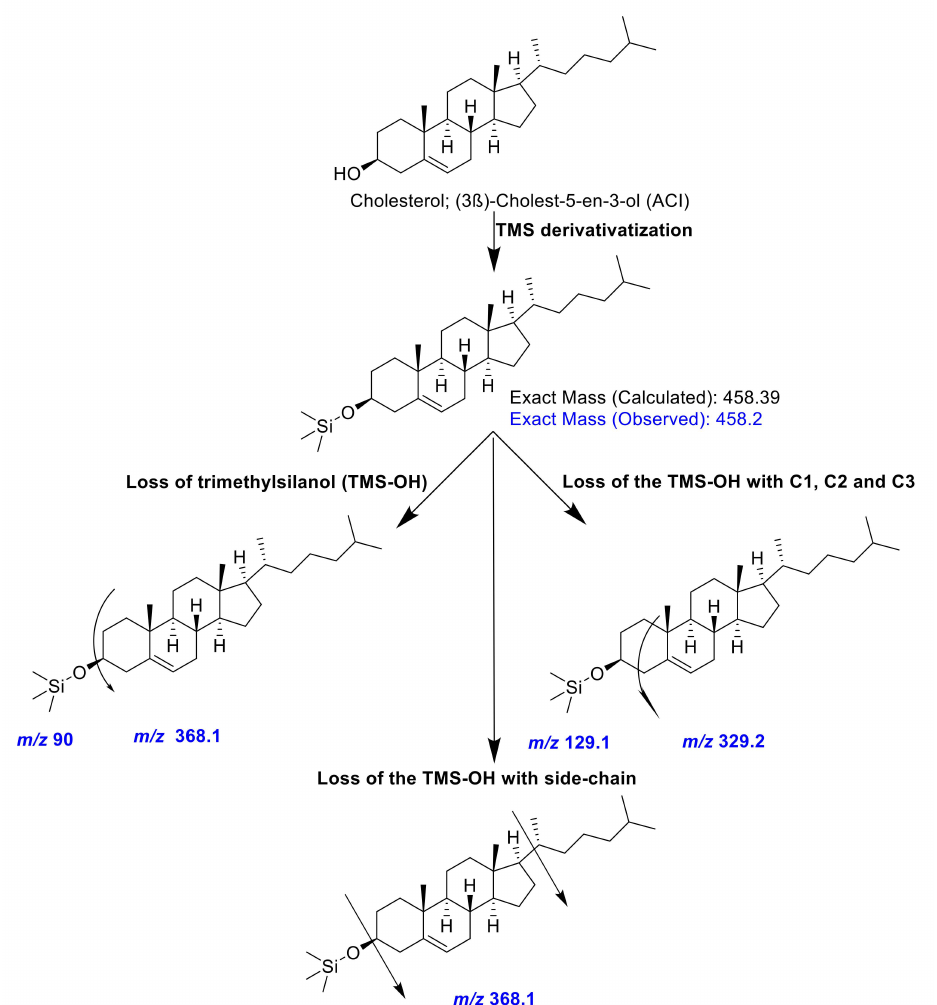
Figure 1. A representative mass-fragmentation pattern of cholesterol (trimethylsiloxy [TMS] derivative) observed in the present investigation. The colored text explains the observed m/z